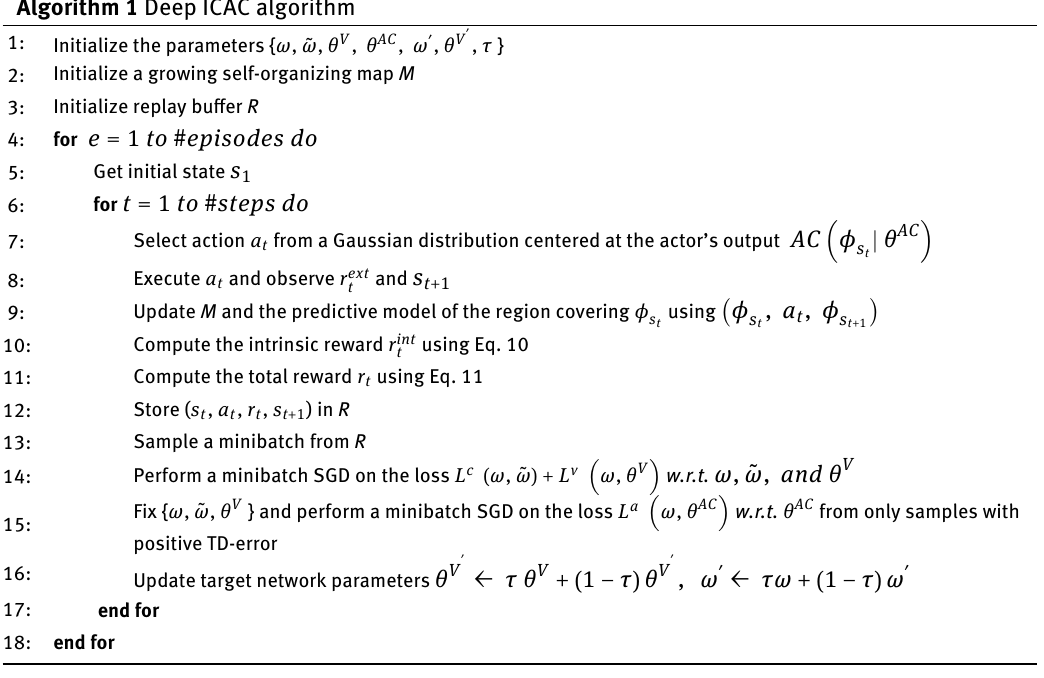
Algorithm 1 Deep ICAC algorithm